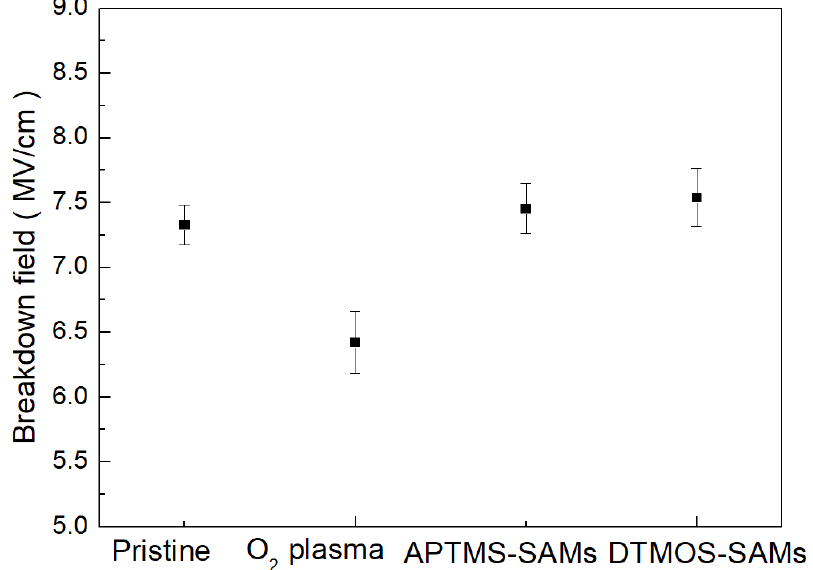
Figure 3. J-E curves of pristine, O 2 plasma-irradiated, APTMS-SAMs, and DTMOS-SAMs p-SiOCH films.